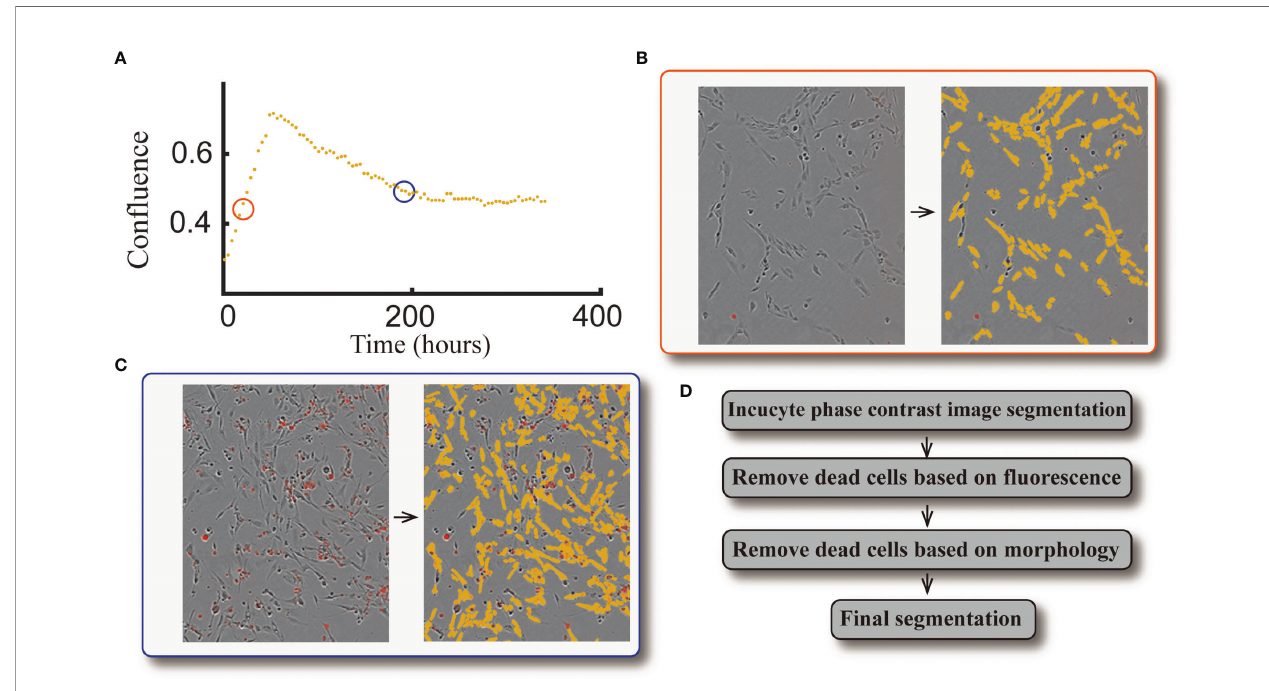
FIGURE 3 | Example of cell response curve and image segmentation. Panel (A) shows the cell response curve from one replicate of the 9L cell line treated with four fractions of 4 Gy. The left portion of Panel (B) is the raw data at 40 hours [indicated by the orange circle in panel (A) ] obtained via live cell microscopy. The image is presented as phase-contrast with a red fl uorescent label indicating dead cells. The corresponding segmentation (highlighted by yellow) is on the right portion of panel (B) . The left portion of Panel (c) is the raw data at 190 hours [indicated by the blue circle in panel (A) ], where there are a large number of dead cells compared to the early time point. The corresponding segmentation is presented in the right portion of the panel. Panel (D) brie fl y summarizes our segmentation pipeline; details were provided in ref.